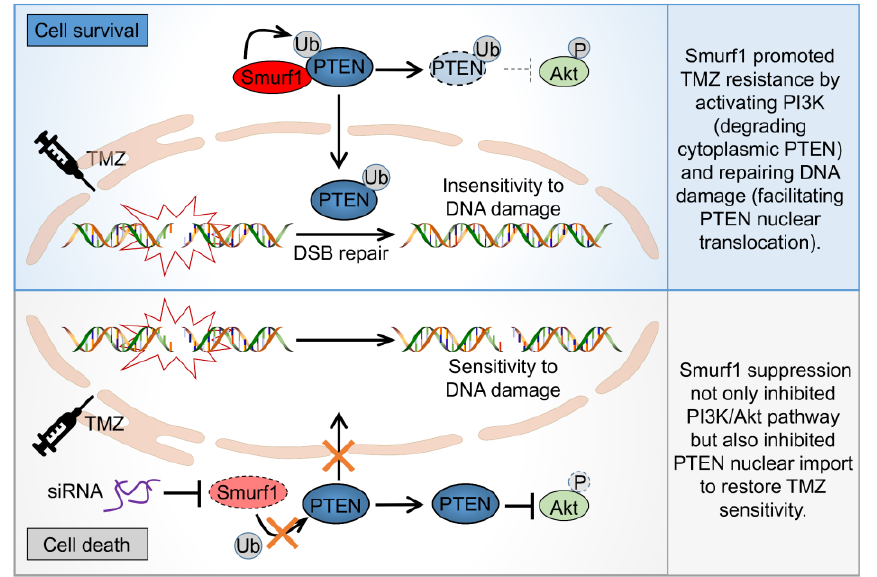
Figure 5. Model of synthetic effect of suppression of Smurf1 and TMZ treatment in PTEN wild-type GB cells. Model of GB restores sensitivity to TMZ by targeting Smurf1. Smurf1 interconnectedly regulates PTEN to activate PI3K/Akt (degradation of cytoplasmic PTEN) and repair DNA damage (import of nuclear PTEN), further promoting TMZ resistance. Smurf1 suppression not only inhibited PI3K/Akt pathway but also inhibited PTEN nuclear import to restore TMZ sensitivity.